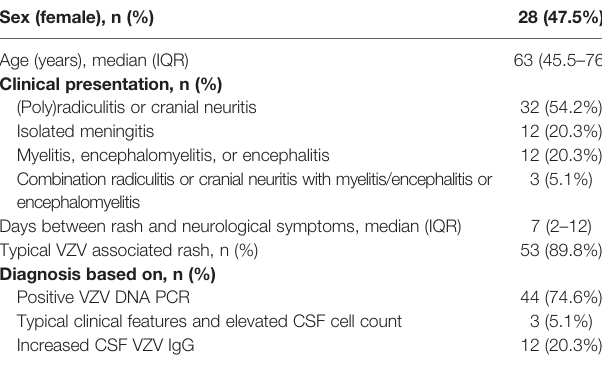
TABLE 1 | Demographic and clinical data of patients with varicella zoster virus infection with central nervous system